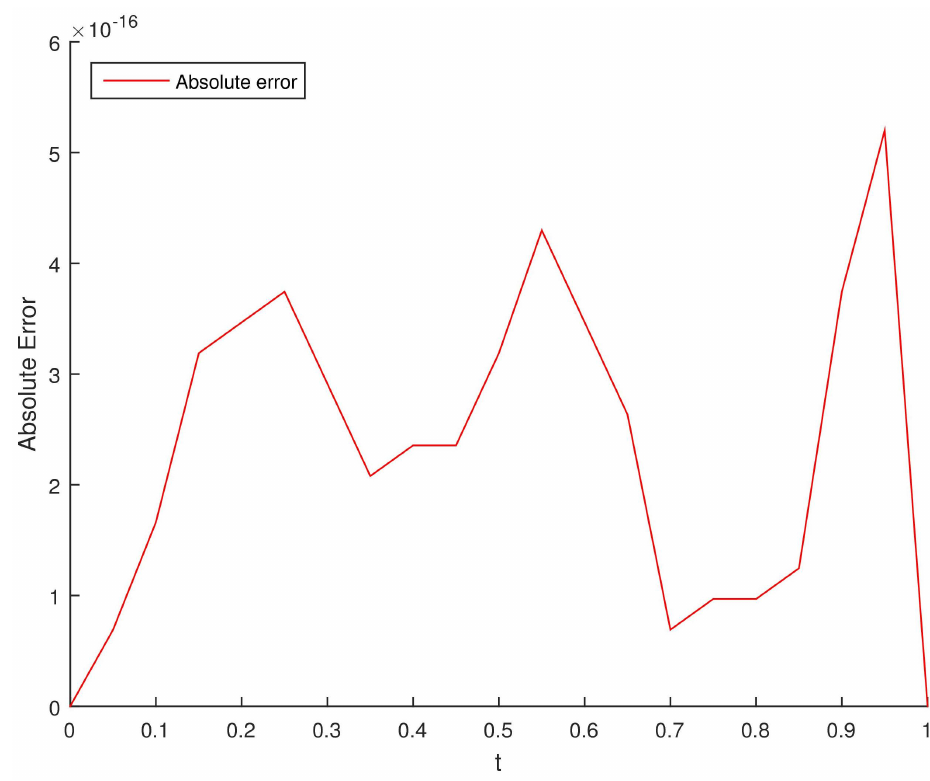
Figure 5. Acquired absolute error of Example 2 for τ = 0.01.